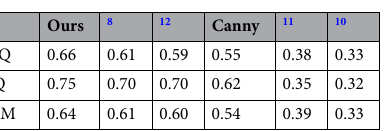
Table 1. Performance comparisons of different methods, d 0